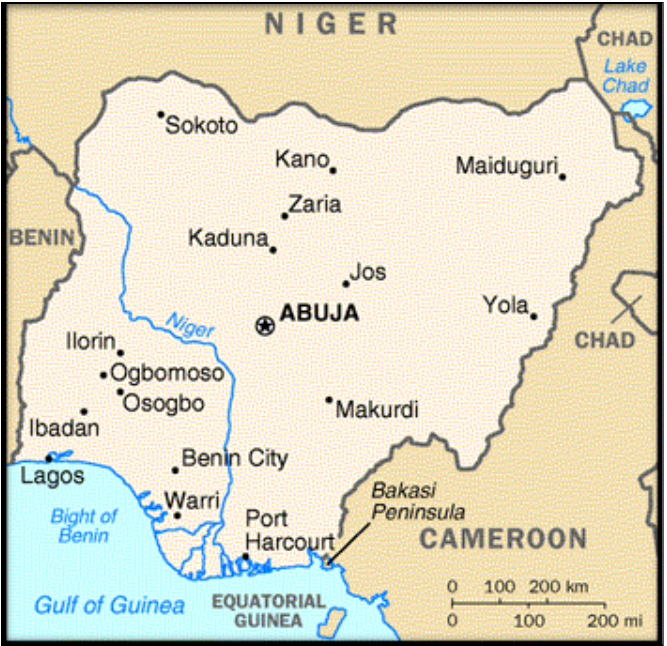
Fig. 1. Map of Nigeria showing geopolitical regions.